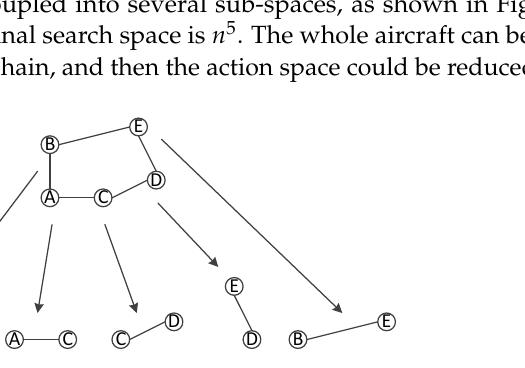
Figure 16. Decomposition of conflict connection. Reprint with permission from [22]. 2014, Jian. Different from n-step RL, it is not necessary to control the aircraft in a fixed time step in the process of ATC. In [33], a K-Control Actor-Critic algorithm is proposed, where K represents the number of control times. On the premise of no conflict, the fewer control times, the better. The K-Control Actor-Critic algorithm is shown in Algorithm